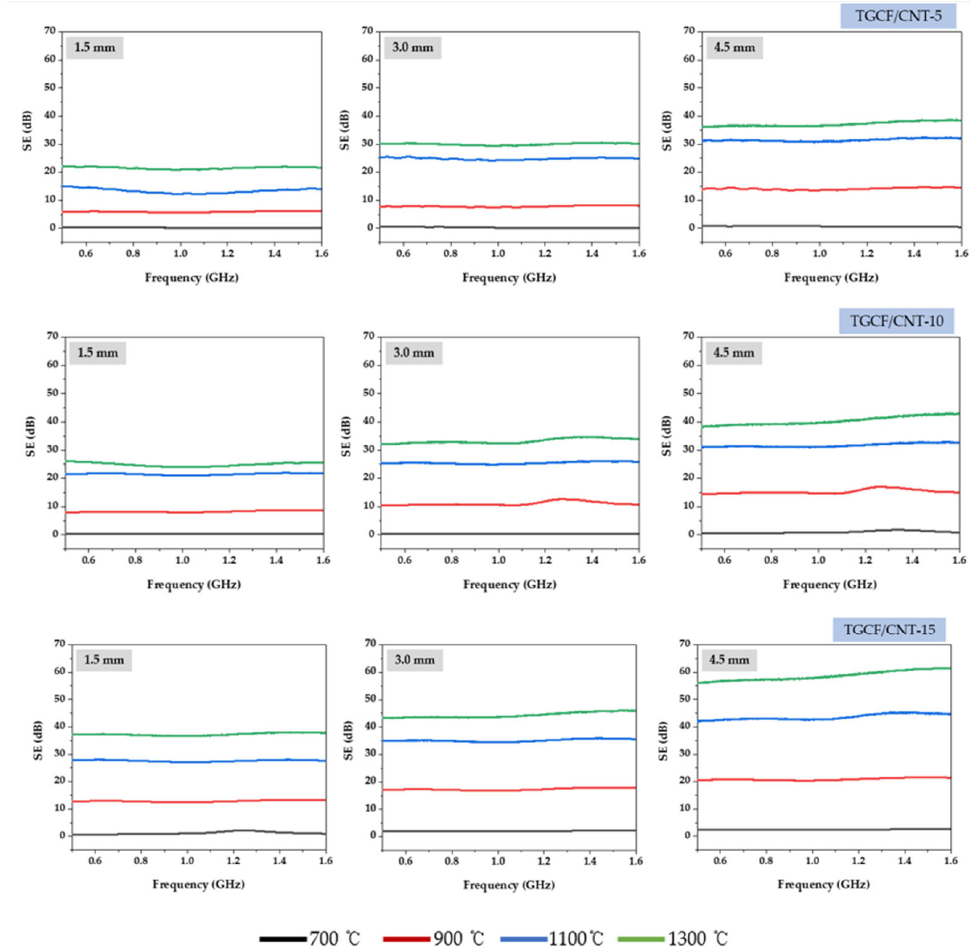
Figure 3. Electromagnetic interference shielding effectiveness of TGCF/CNT carbon papers obtained according to various carbonization temperatures, thicknesses, and carbon nanotube (CNT) content.